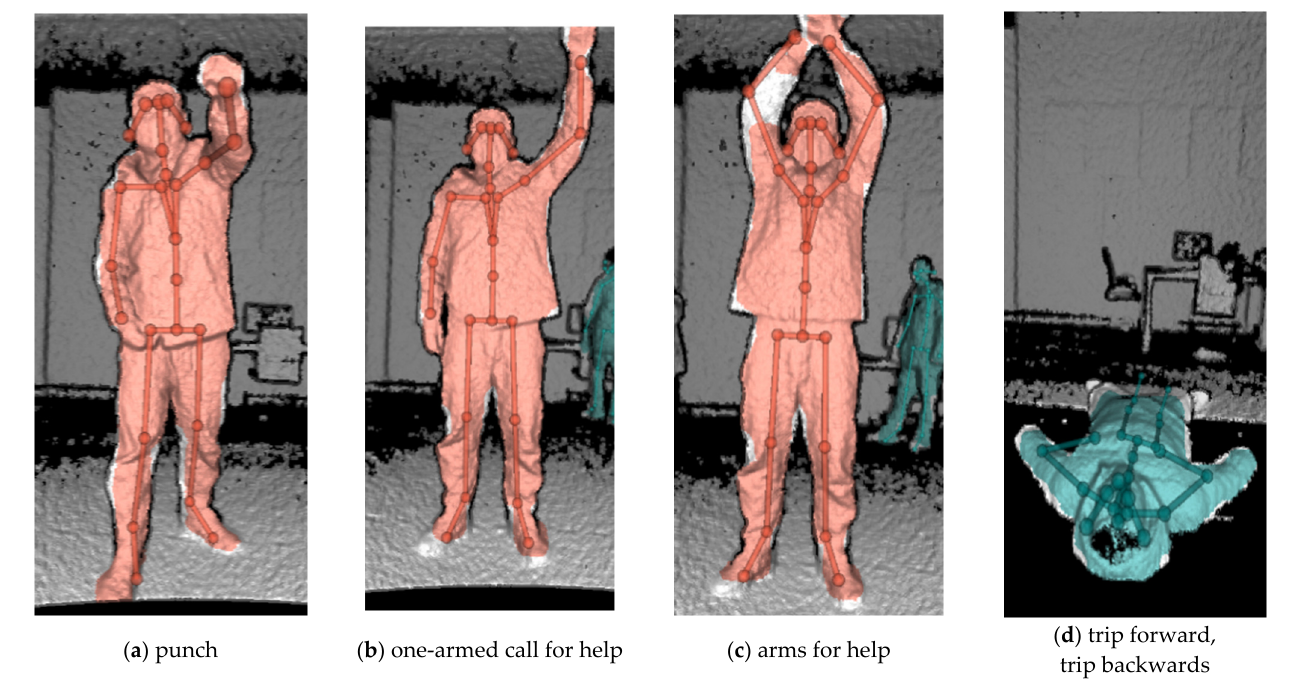
Figure 8. Experimental data collection interface.